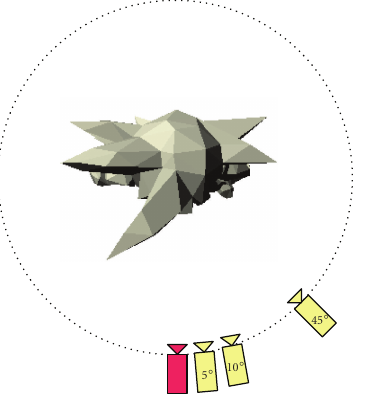
Figure 7: Goku model: camera positions (the available view and depth map correspond to the red camera).